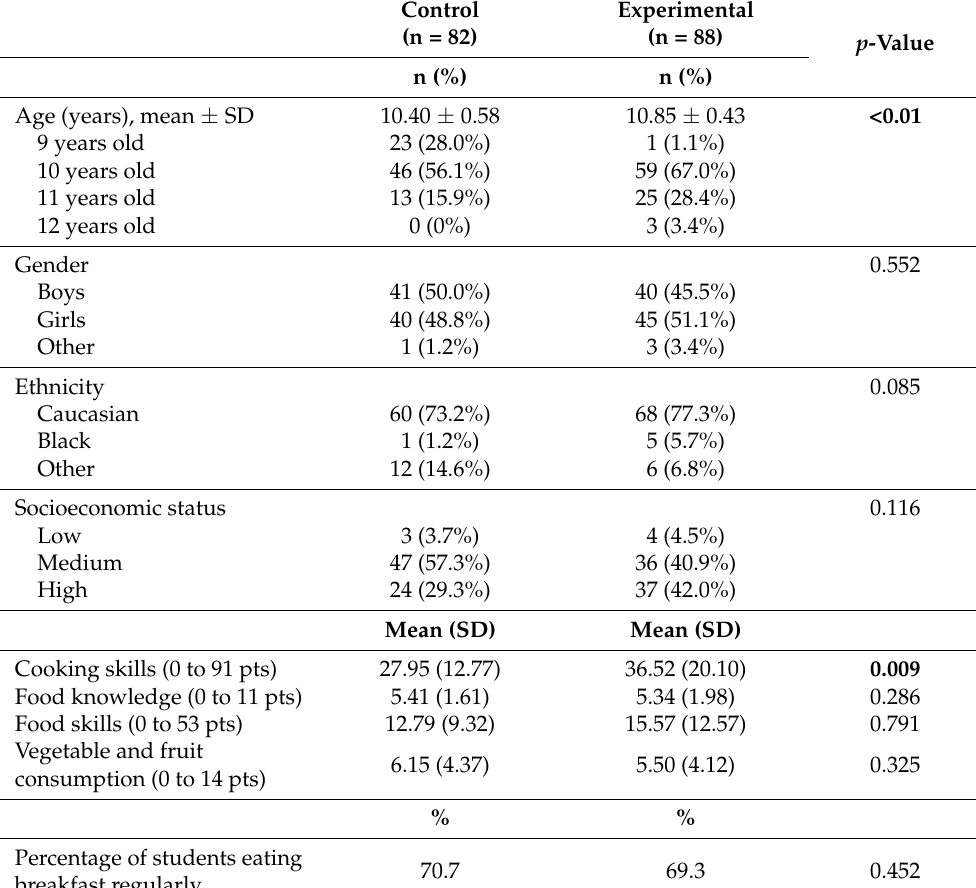
Table 1. Descriptive characteristics of the study sample at